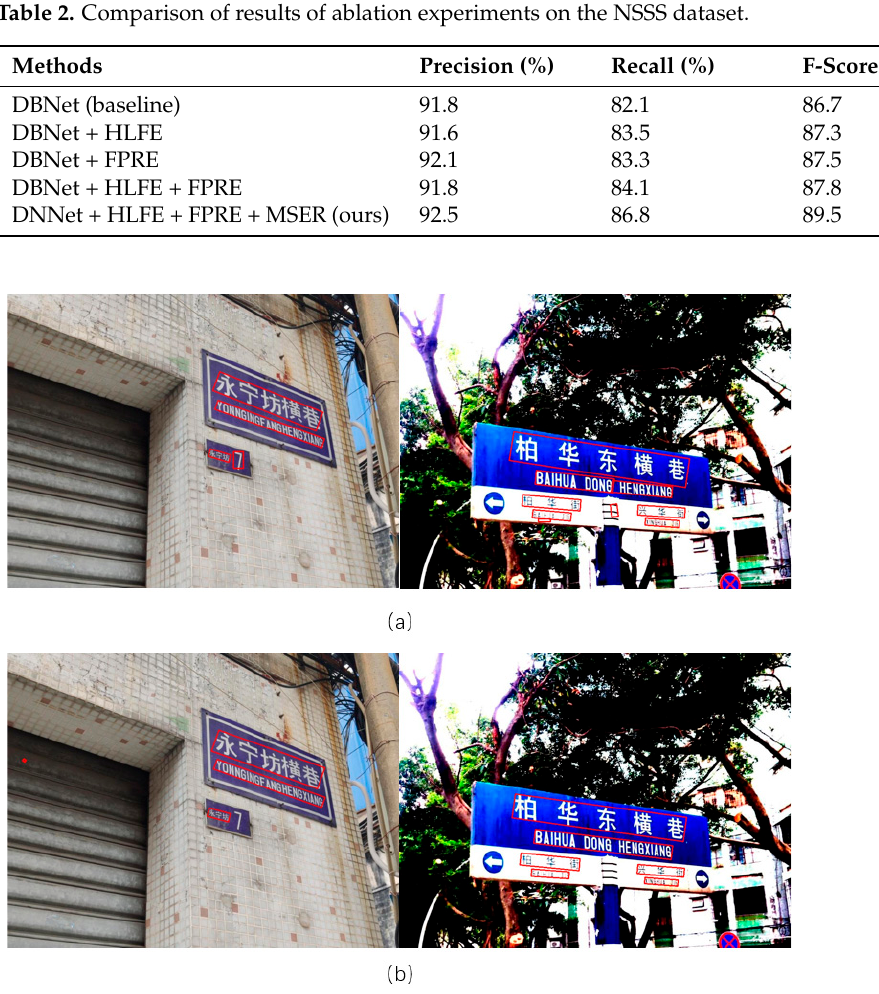
Figure 9. Comparison of visualization results of the method proposed in this paper and original DBNet model on natural scene street sign (NSSS) dataset: ( a ) is the result of the proposed method in this paper, and ( b ) is the result of the original DBNet